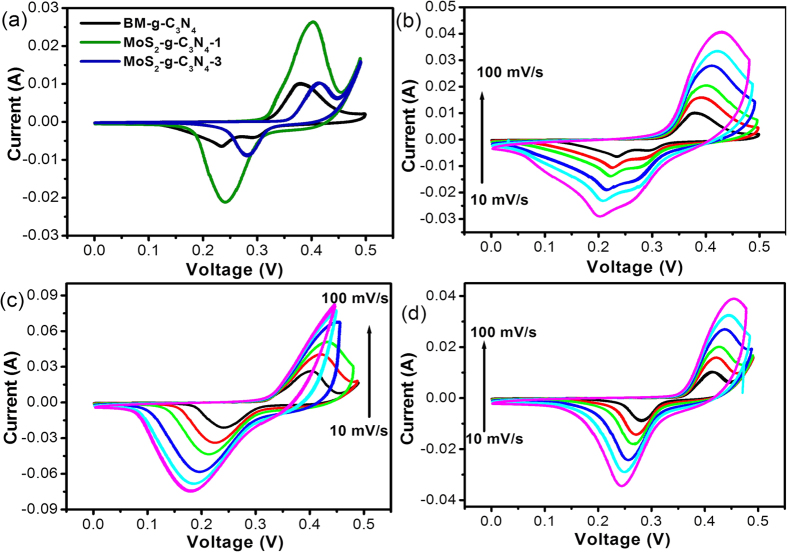
(a) Comparative cyclic voltammogram of the BP-g-C3N4, MoS2-g-C3N4-1, and MoS2-g-C3N4-3 heterostructure at a scan rate of 10 mV s−1, (b) cyclic voltammogram of BM-g-C3N4 at a scan rate of 10–100 mV s−1, (c) cyclic voltammogram of MoS2-g-C3N4-1 at a scan rate of 10–100 mV s−1, and (d) cyclic voltammogram of MoS2-g-C3N4-3 at a scan rate of 10–100 mV s−1.